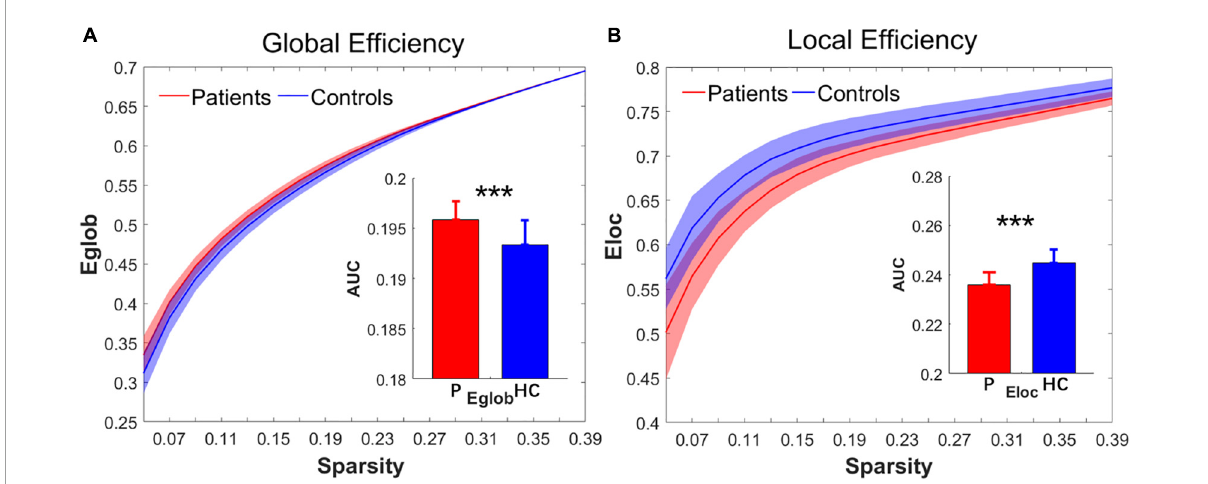
FIGURE2 Group differences in the network efficiency of (A) E glob and (B) Eloc between the IS and control groups in the range of sparsity (0.05–0.4). Bar charts plot the significant differences of the AUC of E glob and E loc between the IS children and controls ( p < 0.05, FDR corrected). ***Significant difference between the two groups. P, patient group; HC, healthy control group.